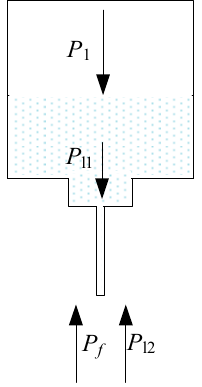
Figure 3. Pressures of the liquid-metal electrode on the nozzle tip.